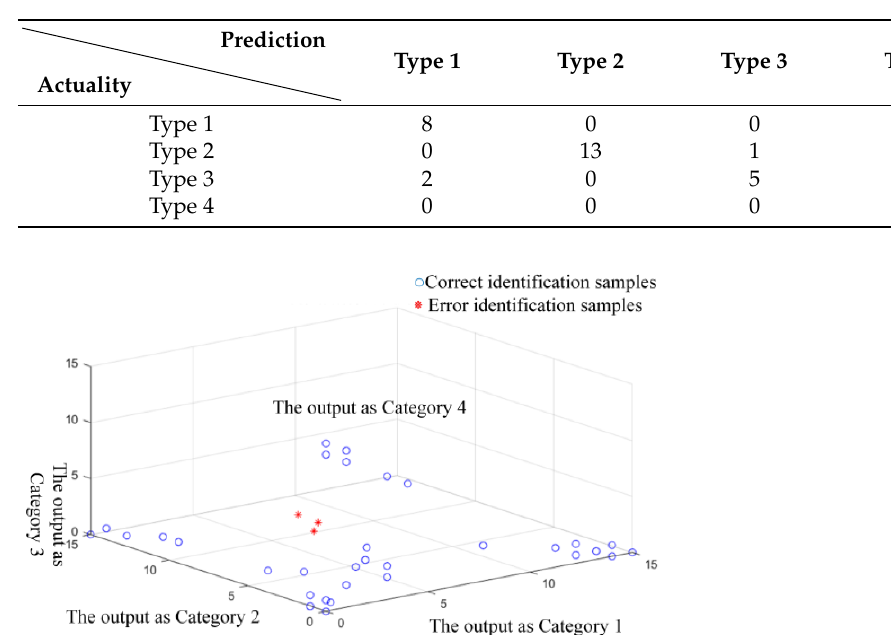
8 of 11 Figure 5. Generation of test set decision tree. The RF algorithm classified the characteristic gas concentration data based on the above DT optimization. The classification results are shown in Table 3 and Figure 6. As shown in the table, the accuracy was 91.43%, with 32 groups identified correctly. Analyz- ing the outcome, the identification of pollution on the insulator surface defect was rela- tively low. This may be because the content of NO 2 under the defect changed more